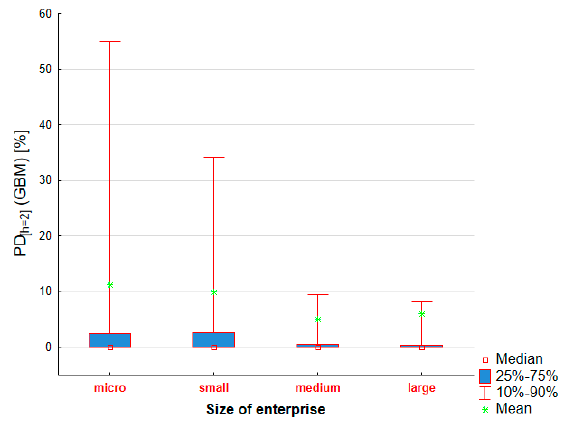
Figure 15. Descriptive statistics characterizing the probability distribution of bankruptcy (over a 2-year time horizon) for the surveyed enterprises from Podkarpackie depending on the size of the enterprise. Source: own elaboration using Statistica.